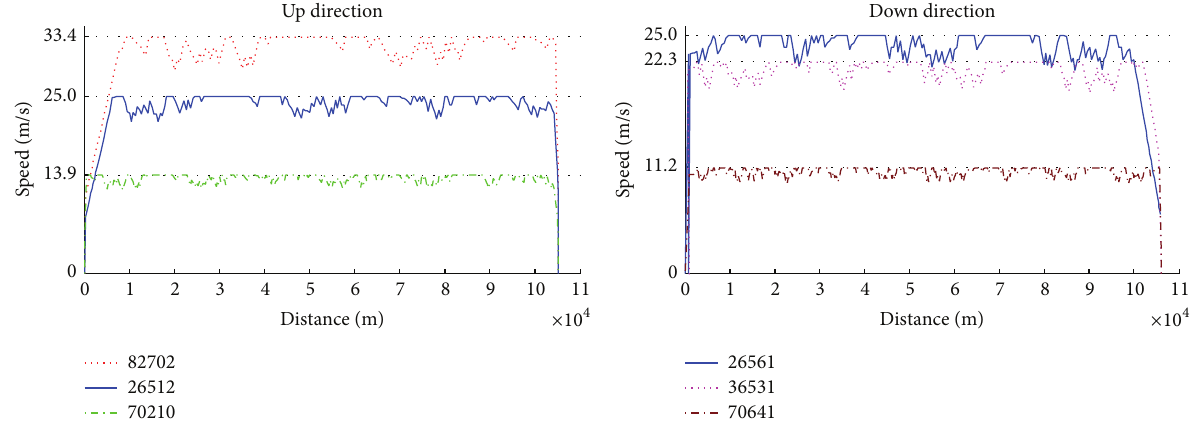
Figure 1: Train speed-distance curve (NCBS: blocking section 1 in the left).